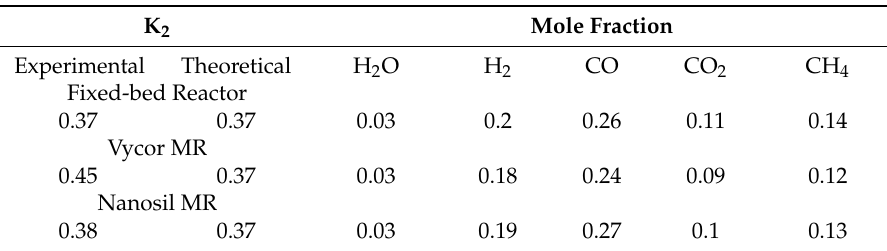
Table 5. Reverse WGS reaction: comparison between theoretical and experimental results for fixed bed reactor, Vycor, and Nanosil MRs. With permission of reprint from Elsevier by Prabhu et al. [37]. K 2 Mole Fraction Experimental